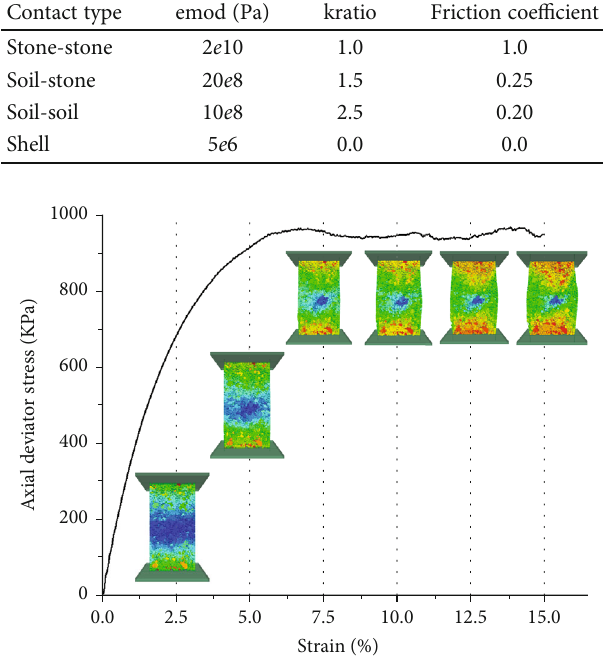
Figure 6: Schematic diagram of specimen compression